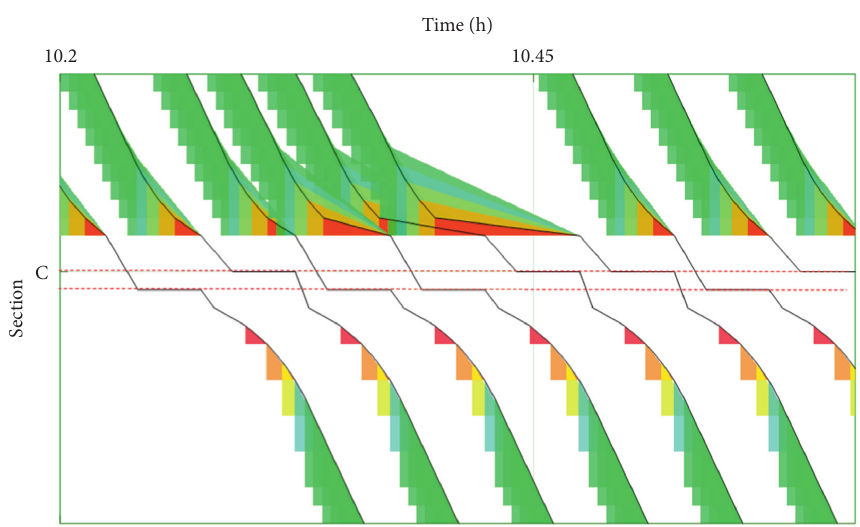
Figure 14: Timetable adjusted with siding line blockage in station C.